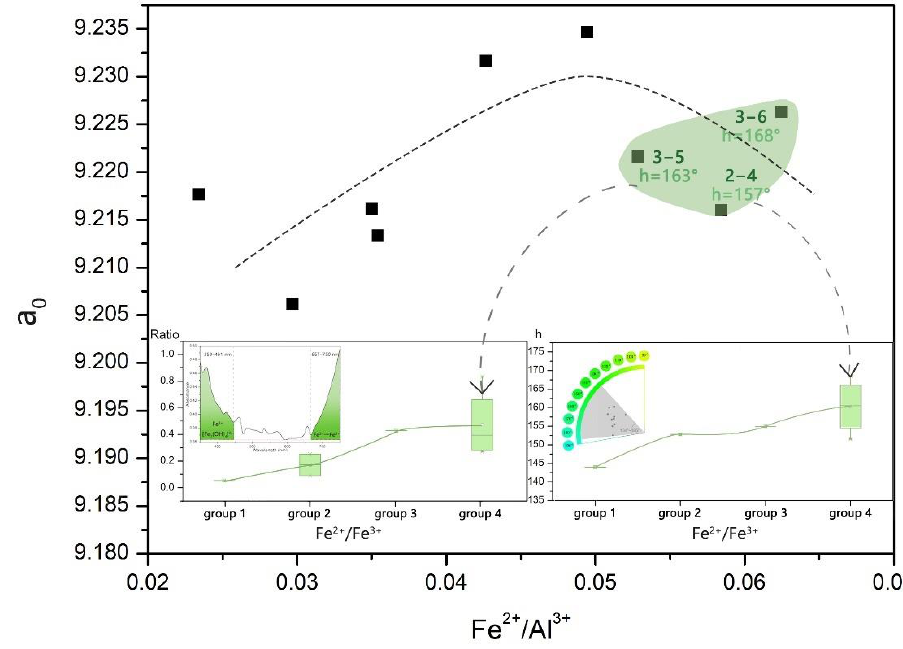
Figure 10. Fe 2+ /Al 3+ content was positively correlated with the cell parameter a 0 at first, but no longer correlated when Fe 2+ reached a certain content. Fe 2+ content was the highest in the 2–4, 3–2, and 3–6 samples, the red area/purple area was the largest in UV–vis spectrum, and the hue angle (h) was the largest. The illustration on the left shows a positive correlation between the Fe 2+ /Fe 3+ content and the red region absorption area/purple region absorption area in the UV–vis spectrum. On the right illustration, Fe 2+ /Fe 3+ content was positively correlated with h.